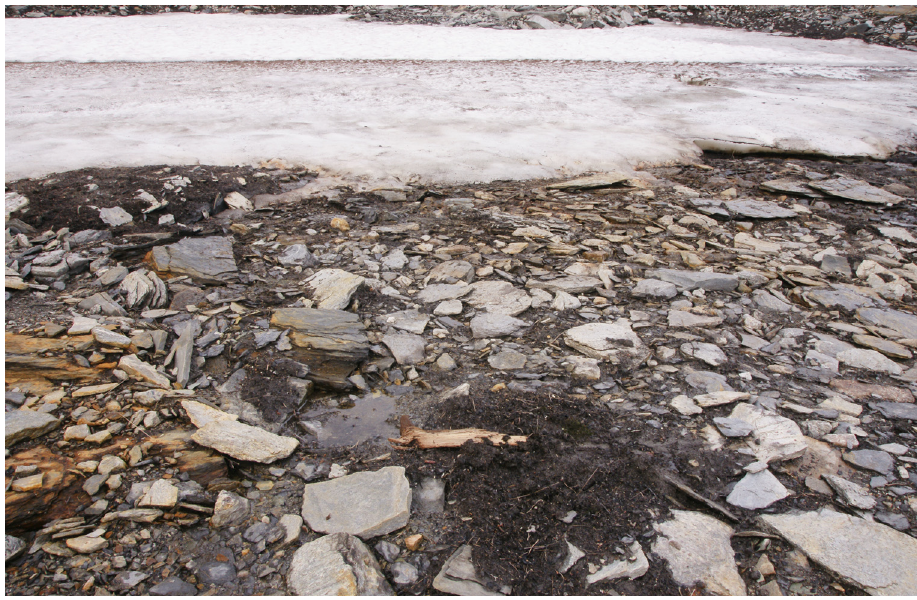
Figure 22: Slåttatjåkka (9). Fragment of pine wood, exposed close to Figure 21. 9440 cal. yr